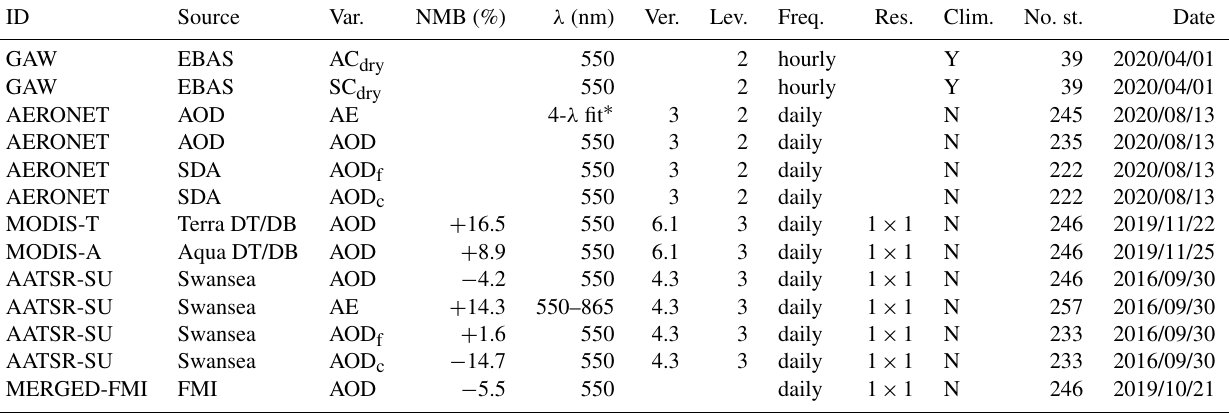
∗ AERONET’s 4- λ fit is based on these four wavelengths: 440, 500, 675, and